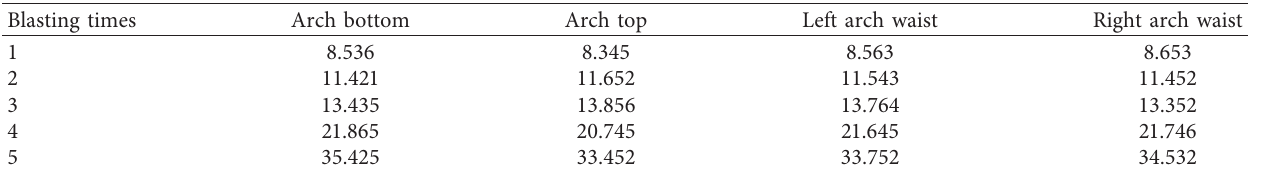
Table 4: Peak displacement at each measuring point of 5-5 profile (mm).